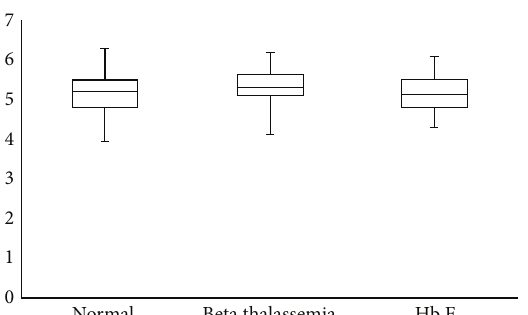
Figure3:Boxplotshowingquartiles1,2,and3forHbA1cinnormal chromatograms, beta thalassemia trait, and Hb E trait.